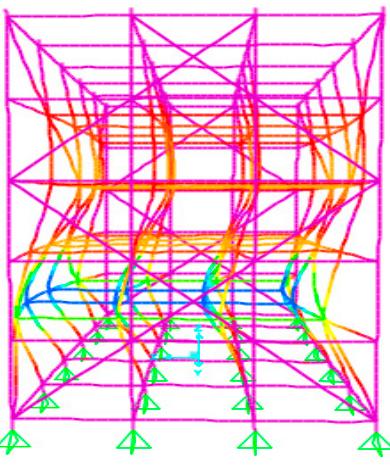
Figure 3. First-order buckling mode under static condition.